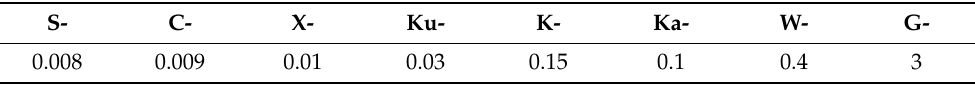
Table 4. Near surface one-way atmospheric gas specific attenuation k λ gas [dB km − 1 ] at each radar band approximated by visually examining Figure 1 contained in [31]. Estimates in [31] assume